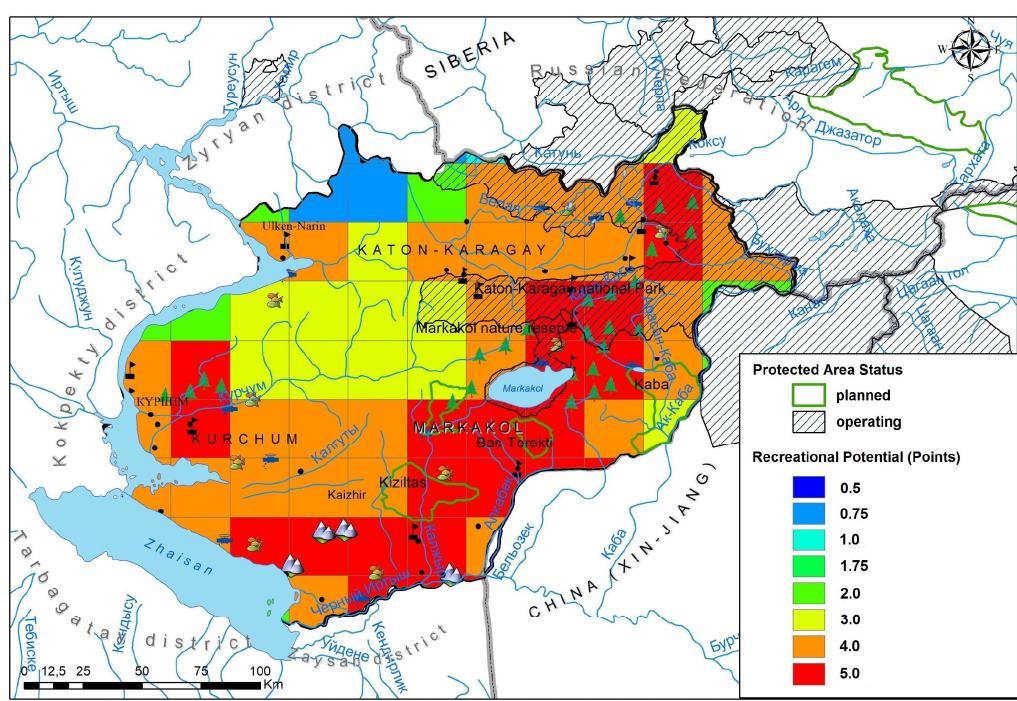
Figure 5. Generated model map of the geo/ecotourism potential and the recreation attractiveness in the Southern Altai on the territory of eastern Kazakhstan (the Southern Altai area).